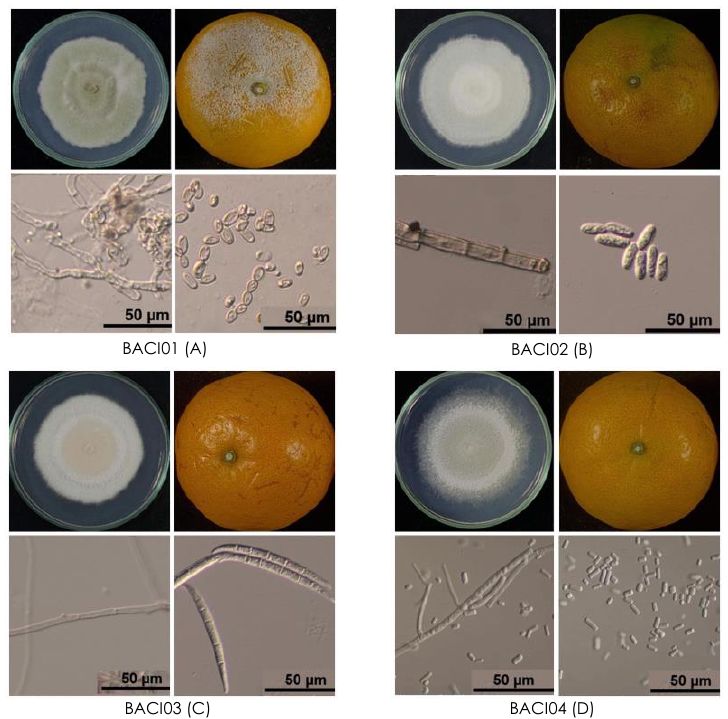
Figure 4. Morphological characteristic and pathogenicity of ‘Sai-Namphaung’ tangerine postharvest fungal isolates. ( A ) Penicillium sp. ( B ) Colletotrichum sp. ( C ) Fusarium sp. ( D ) Geotrichum sp. Table 2. Morphology of fungal isolates collected from ‘Sai -Nam phaung’ tangerine fruits during postharvest.